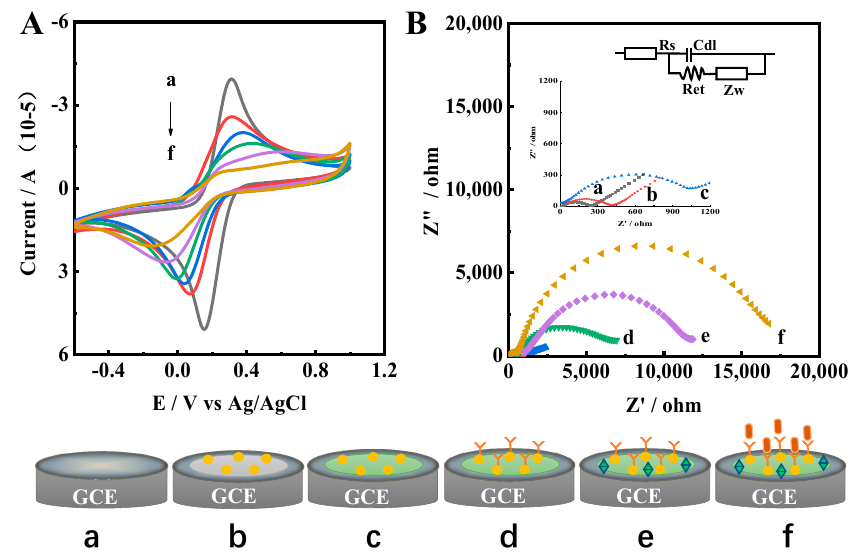
Figure 3. ( A ) CV and ( B ) EIS curves of a: bare GEC; b: Ir − NCDs/PDDA; c: Ir − NCDs/PDDA/GA; d: Ir − NCDs/PDDA/GA/Ab; e: Ir − NCDs/PDDA/GA/Ab/BSA; and f: Ir − NCDs/PDDA/GA/Ab/BSA/SE. The EIS spectra were obtained with a 5 mM [Fe(CN) 6 ] 3- / 4- solution using a frequency range of 0.1 MHZ–0.1 Hz, a bias potential of 0.225 V and an AC amplitude of 5 mV.